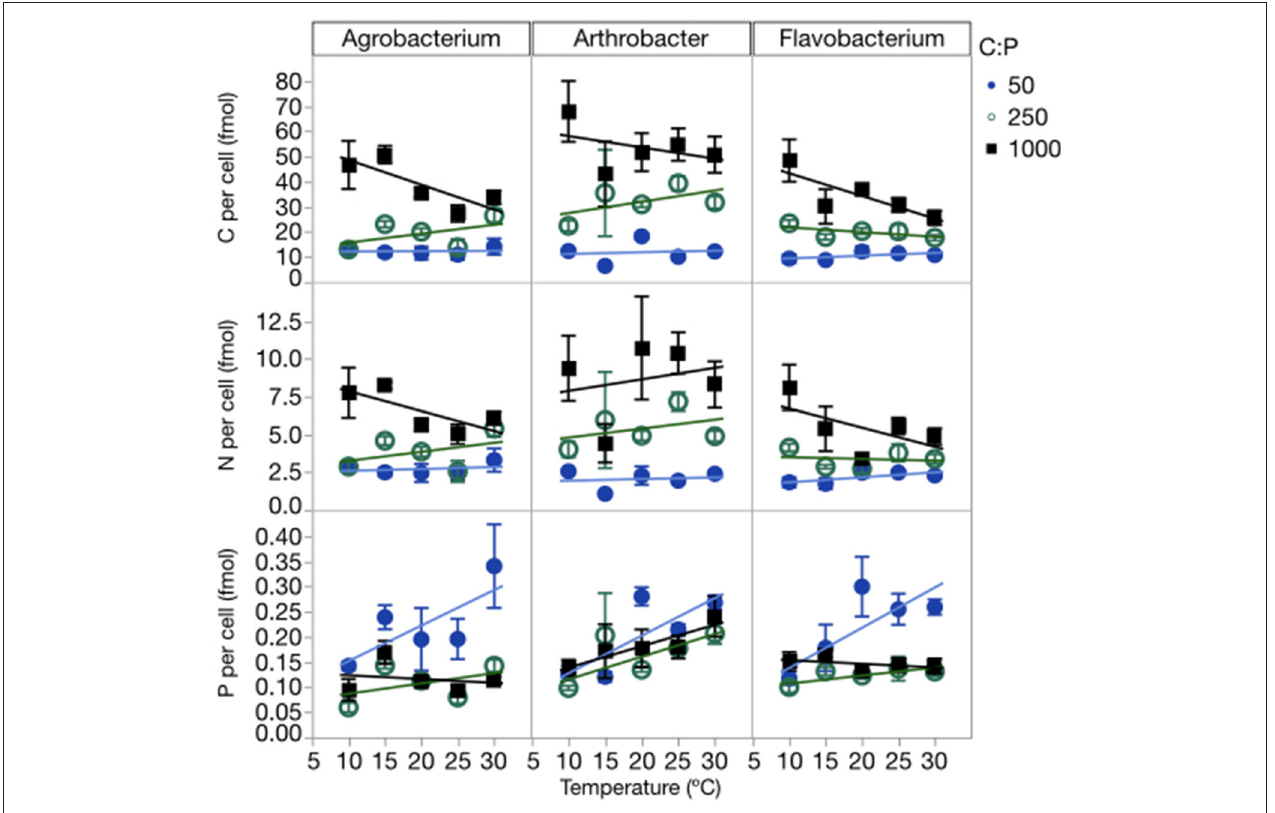
FIGURE 3 | Changes in cellular C, N, and P quotas of each strain across temperatures, with different symbols for each level of C:P R . Error bars represent one standard error of the